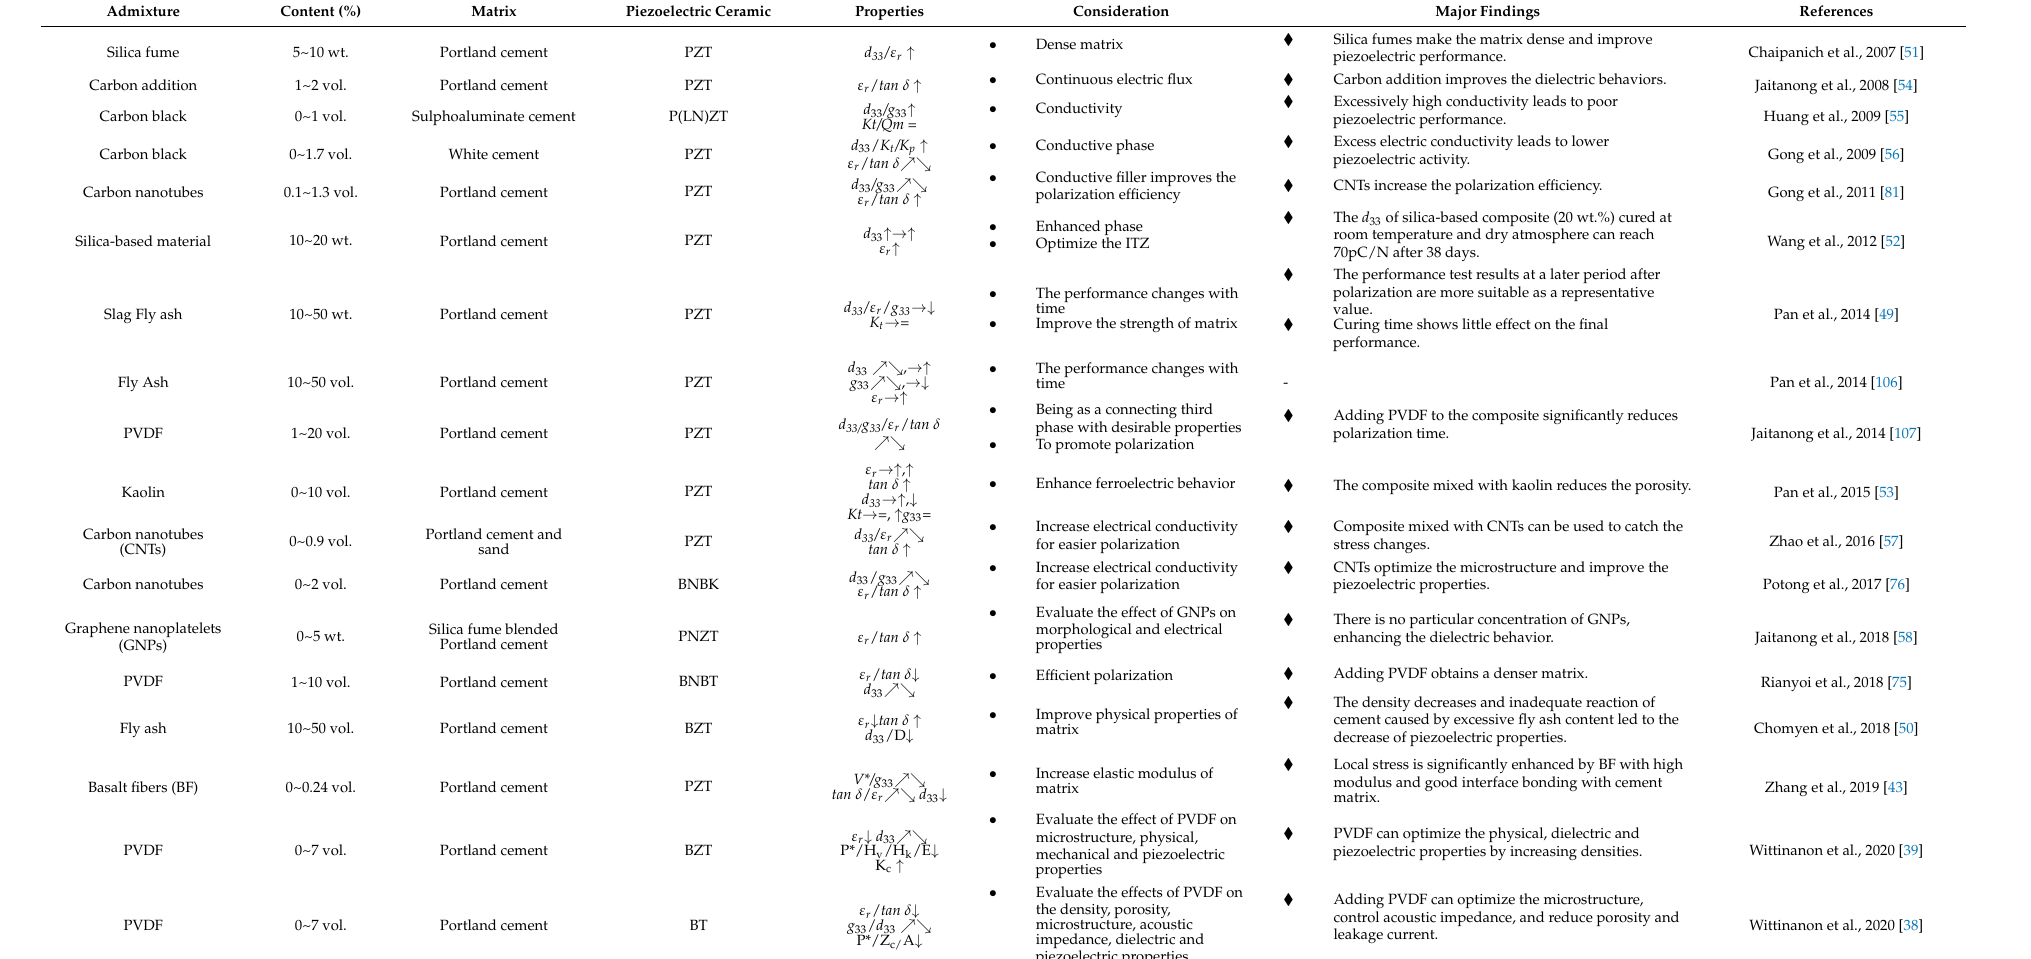
Table 5. Influence of admixture on the performance of CPCs.